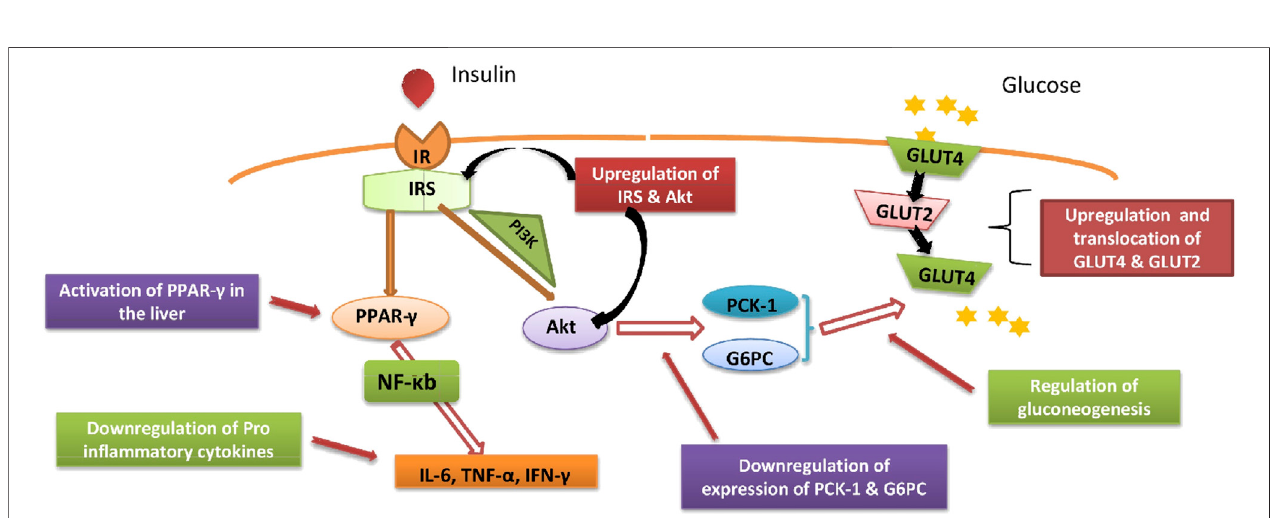
FIGURE 6 | Schematic depiction of the possible cellular mechanism underlying Anti-diabetic Potential of Senna auriculata (L.) Roxb. in Type II DM.